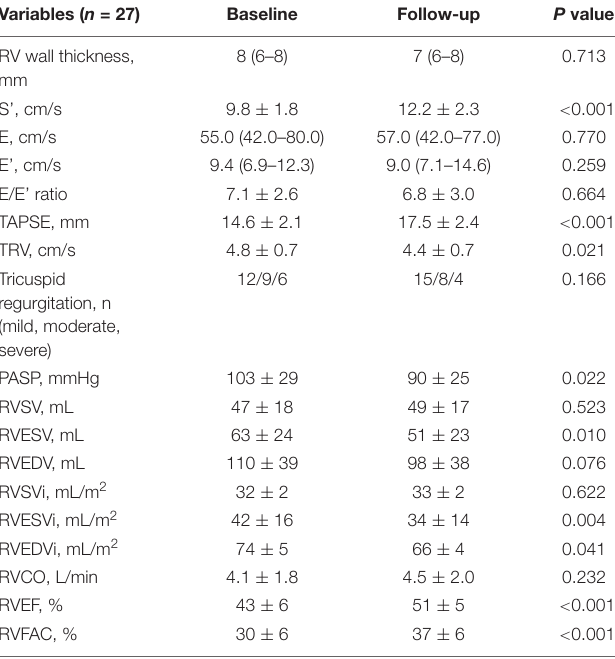
TABLE 3 | Echocardiographic parameters at baseline and